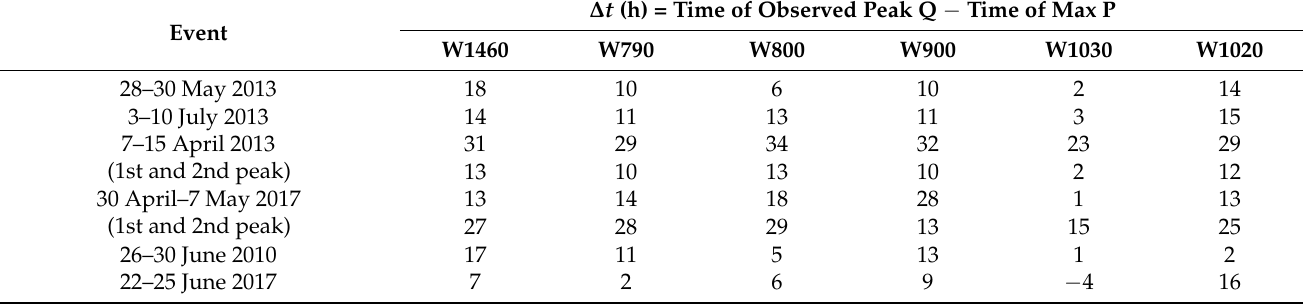
Table 3. Time difference between the time of the observed peak discharge and the time of the peak precipitation intensity for the six studied precipitation